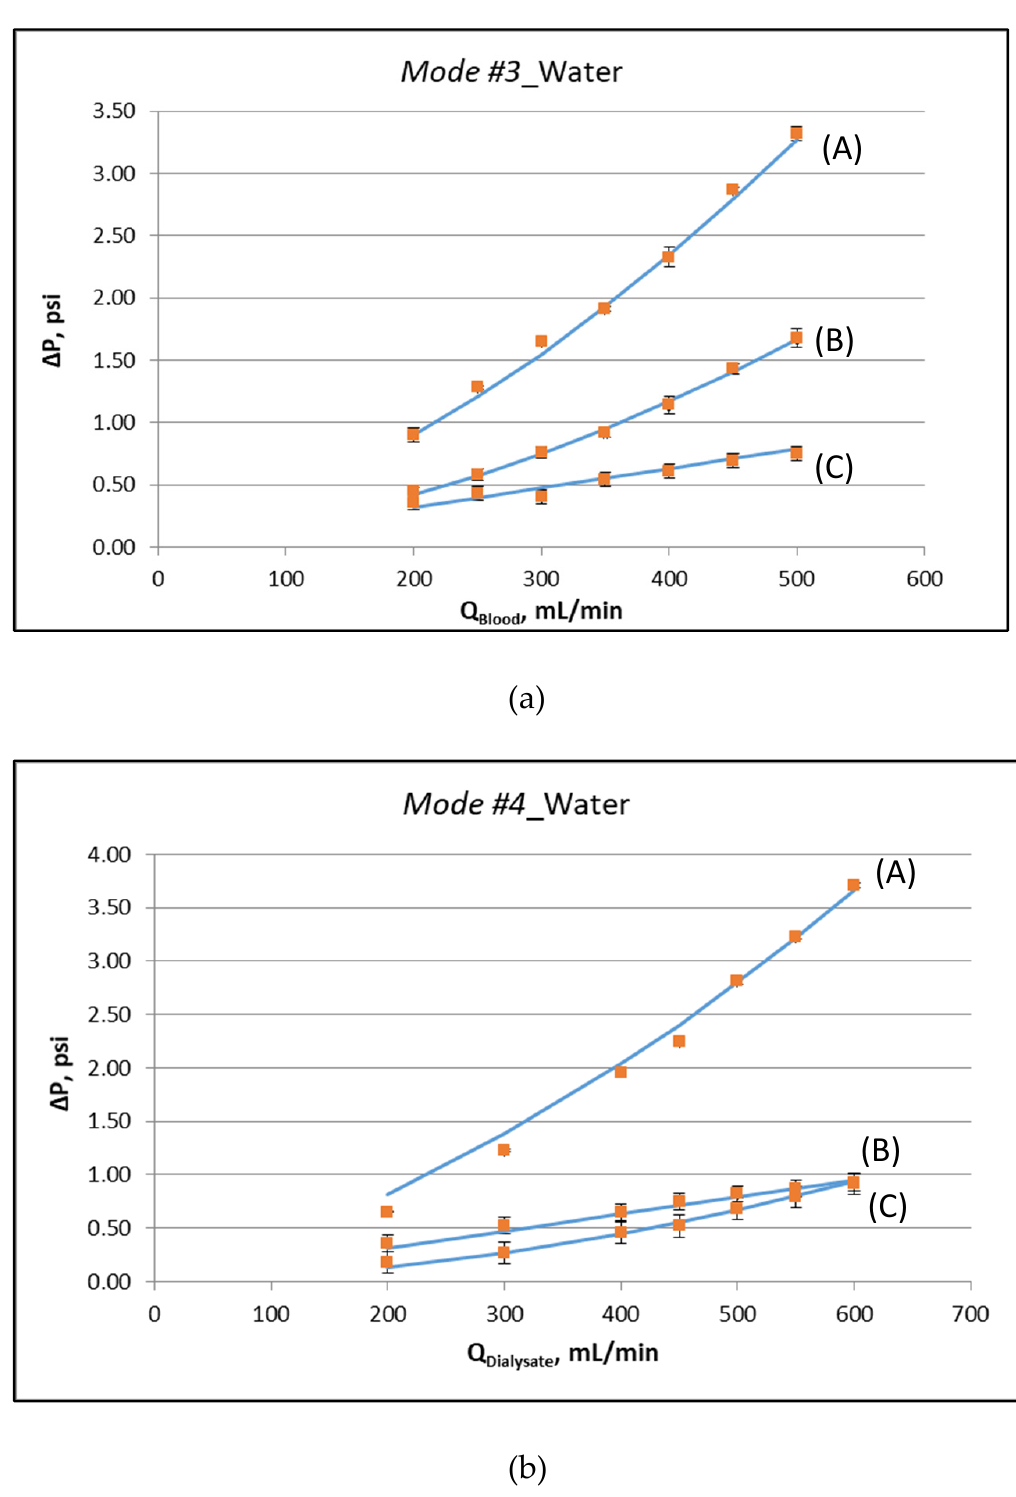
Figure 3. Determination of fluid-mechanical parameters by appropriate data fitting [12], using external pressure differences, for operating Mode #3 and Mode #4 . ( a ) Operating Mode #3: (A) Δ P = P 1 − P 4 , (B) Δ P = P 1 − P 2 , (C) Δ P = P 2 − P 3 , ( b ) Operating Mode #4: (A) Δ P = P 3 − P 2 , (B) Δ P = P 3 − P 4 , (C) Δ P = P 4 − P 1 . Detailed experimental data are listed in the Supplement (Table S1). Table 1. List of determined parameter values from fitting the model to experimental data.